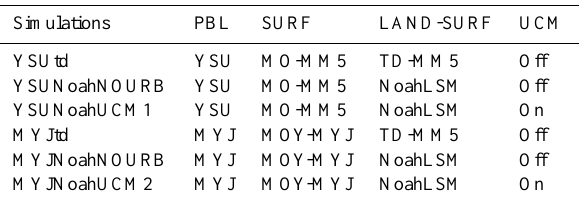
Table 1. Outline of performed simulations. In the first column, the identification acronym of each simulation is shown. In the other columns, the parameterizations used are indicated (see the text for